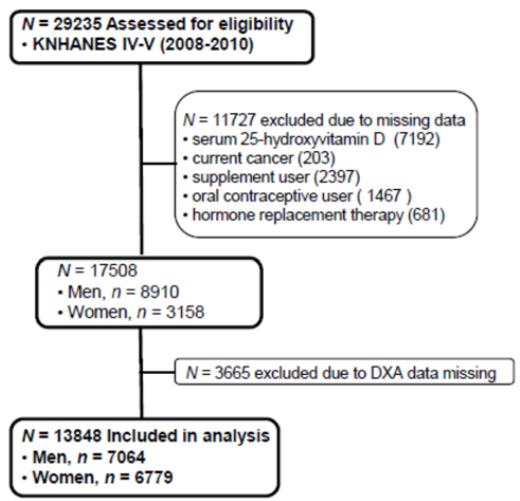
Figure 1. Flow diagram of subject inclusion and exclusion in the Korea National Health and Nutrition Examination Surveys (KNHANES IV & V). DXA: Dual energy X ‐ ray absorptiometry.